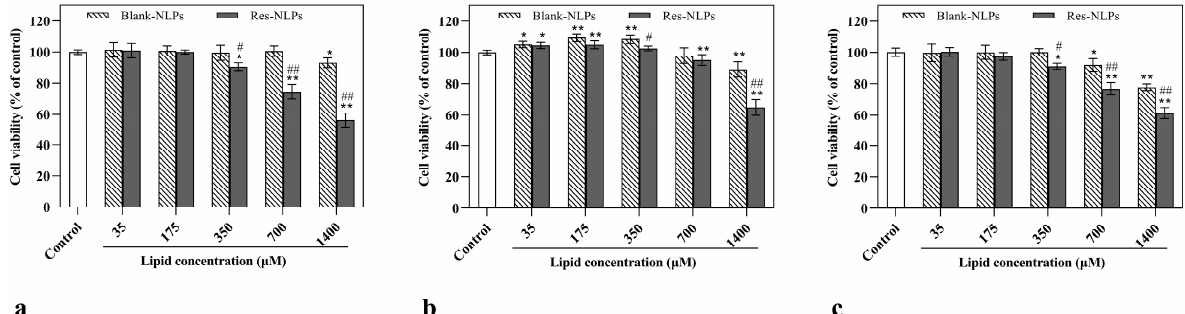
Figure 3. In vitro cytotoxicity of the blank NLPs, Res-NLPs against ( a ) HaCaT, ( b ) HSF and ( c ) B16F10 cells detected by CCK-8. The cells were treated with the blank NLPs or Res-NLPs at the same lipid concentrations over a wide range (35~1400 µ M). The cells treated with DMEM only served as the control group. Mean ± SD ( n = 3). * p < 0.05, ** p < 0.01, compared with the control group, # p < 0.05, ## p < 0.01, compared with the blank NLPs group.